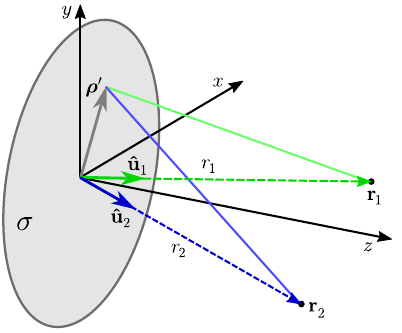
Figure 2. Geometry and notations related to the van Cittert–Zernike